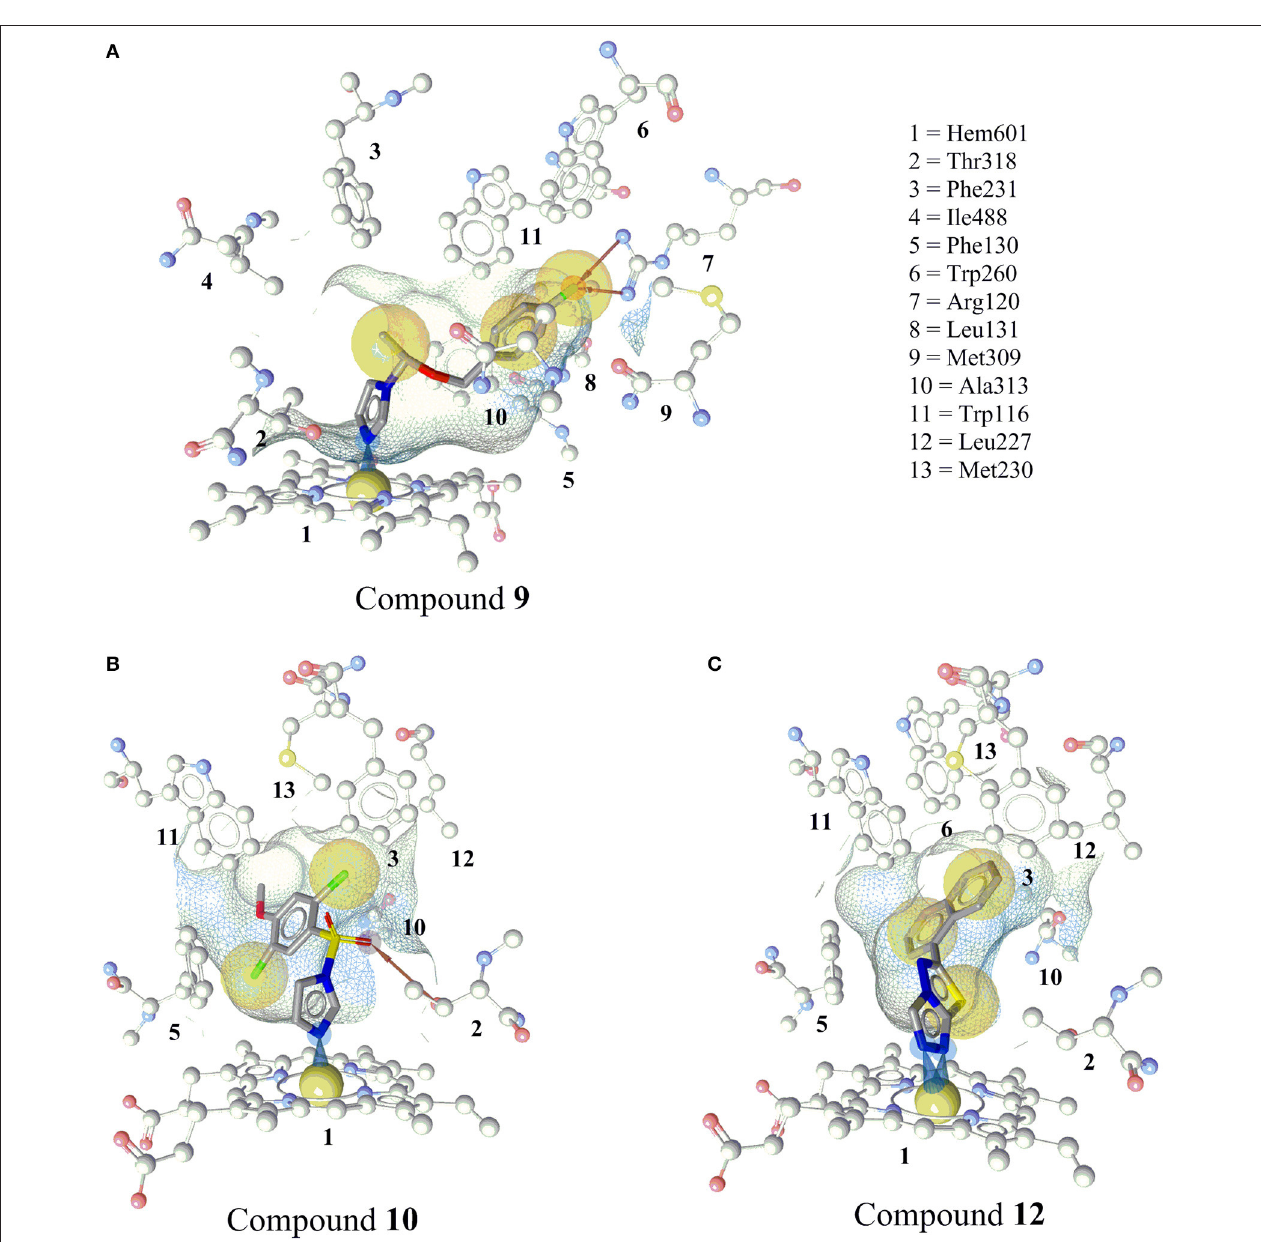
FIGURE 7 | Predicted binding modes of the newly discovered inhibitors 9, 10 , and 12 in CYP11B2 (PDB code = 4FDH). (A) Docking pose of compound 9 showing an iron complex of the imidazole-N with the heme iron and HBA interaction of the fluorine with Arg120. (B) The docking pose of compound 10 showing an iron binding interaction of the imidazole-N with the heme iron, a hydrogen bond between the sulfonamide and Thr318, and hydrophobic interactions of the halogens. (C) Docking pose of compound 12 , a selective CYP11B2 inhibitor. Two N atoms of the triazole ring formed iron-binding interactions with the heme iron. The wire frame network represented the binding pocket, and its surface is colored by aggregated lipophilicity (gray)/hydrophilicity (blue).